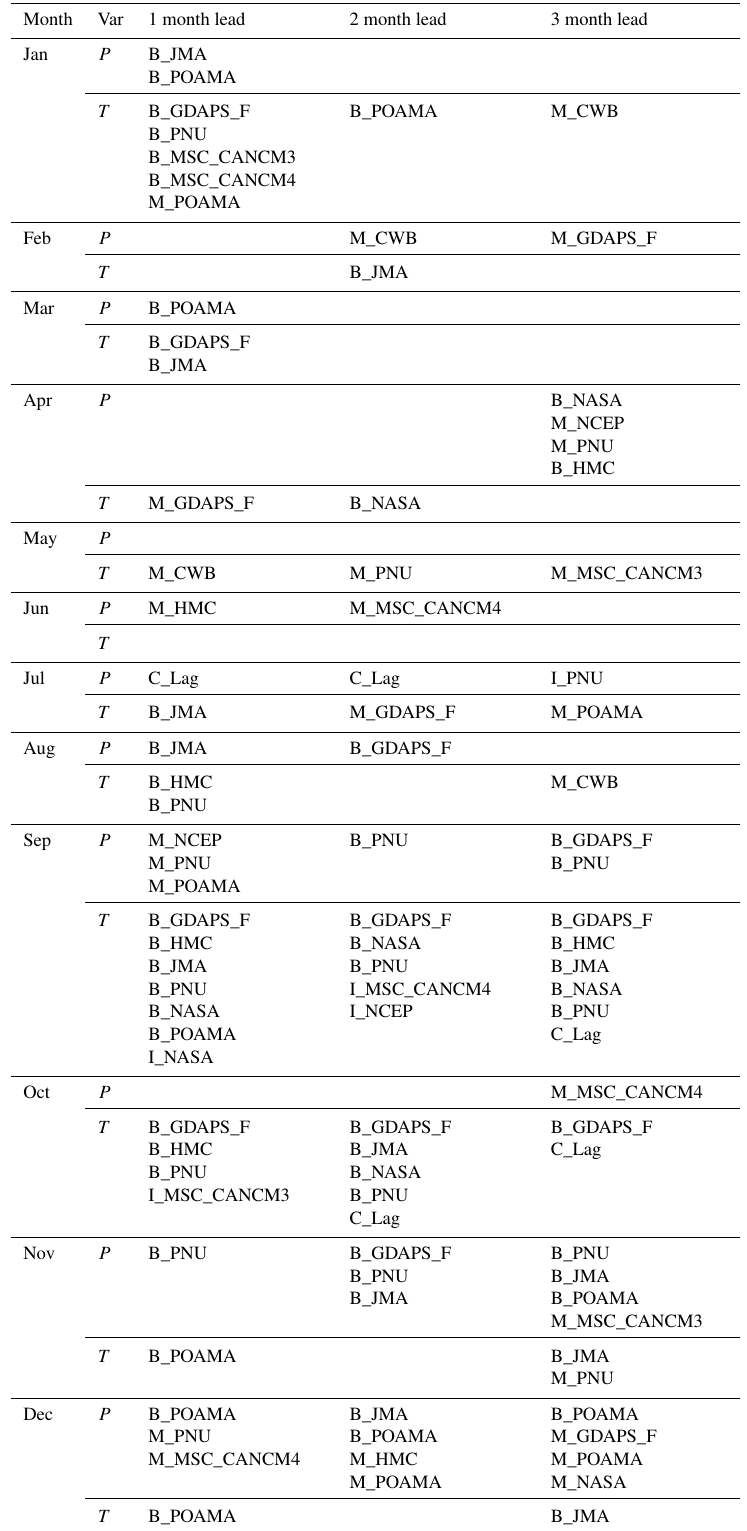
Table 3. Selected downscaling method and models for each month according to different lead time and